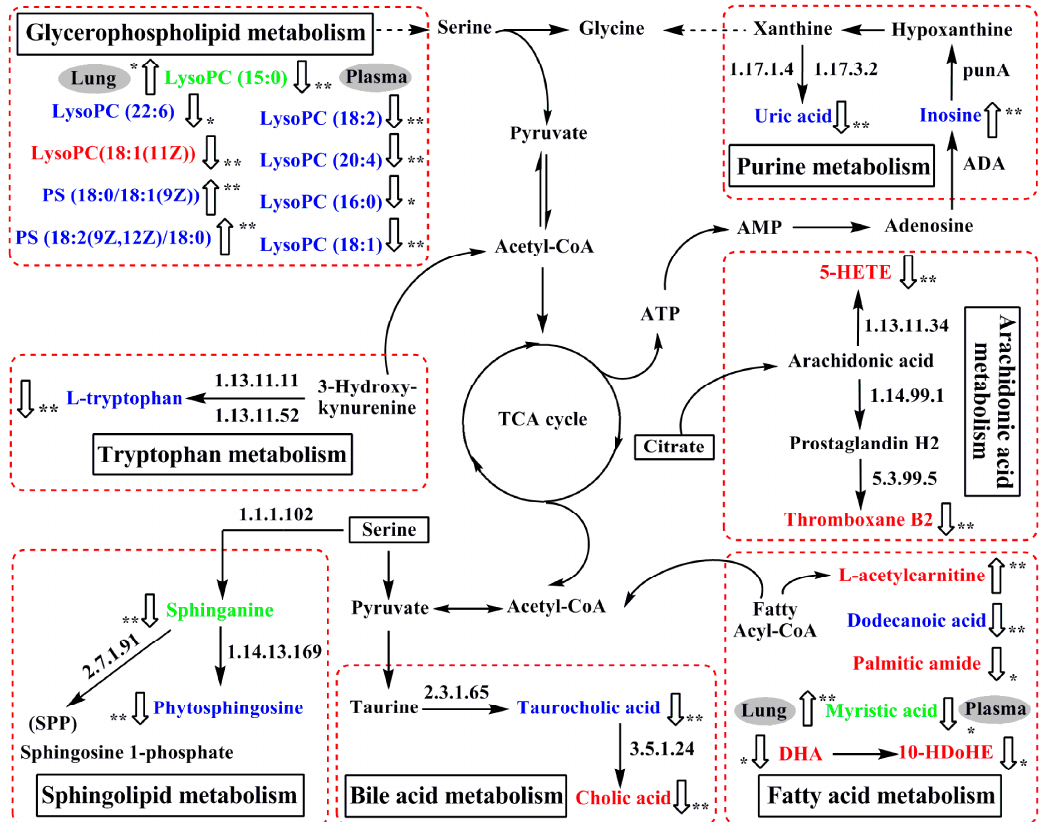
Figure 6. The perturbed network of the potential biomarker associated allergic asthma and the modulation of mKG according to the KEGG database. 1.17.1.4: xanthine dehydrogenase; 1.17.3.2: xanthineoxidase; ADA: Adenosine deaminase; 1.13.11.11: tryptophan 2,3-dioxygenase (TDO); 1.13.11.52: indoleamine 2,3-dioxygenase (IDO); 1.13.11.34: arachidonate 5-lipoxygenase; 1.14.99.1: prostaglandin-endoperoxide synthase; 1.1.1.102: dehydrosphinganine reductase (DSR); 5.3.99.5: thromboxane-A synthase; 2.7.1.91: sphingosine kinase; 1.14.13.169: sphingolipid C4-monooxygenase (SUR2); 2.3.1.65: bile acid-CoA:amino acid N-acyltransferase (BAT); 3.5.1.24: choloylglycine hydrolase. Metabolites measured in lung tissue were labeled in red, metabolites labeled in blue were measured in plasma, and metabolite names in green mean they were measured both in plasma and lung tissue.